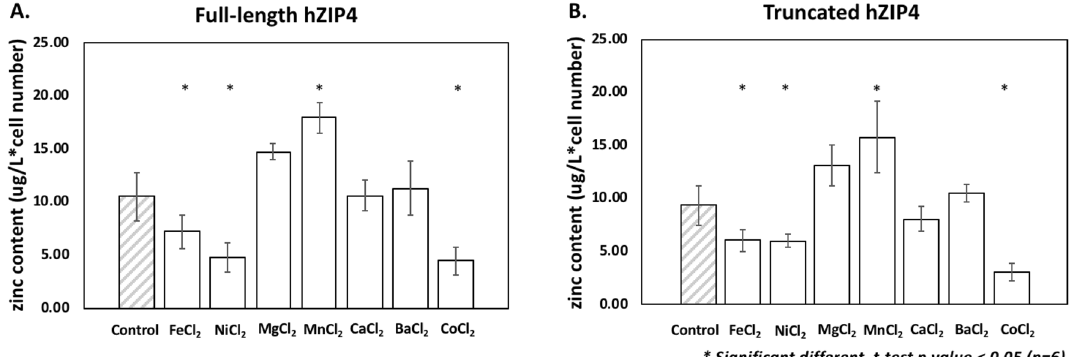
Figure 5. Competition of zinc transport with a series of divalent cations. To exam which divalent cations inhibit hZIP4-meidated Zn 2+ transport. HEK293 cells expressing hZIP4 ( A ) or truncated hZIP4 ( B ) were pre- incubated in 600 µM ZnCl 2 (control), FeCl 2 , NiCl 2 , MgCl 2 , MnCl 2 , CaCl 2 , BaCl 2 or CoCl 2 complemented media, separately. The transport was initiated by adding 5 µM Zn 2+ . * Statistically significant, t-test p value < 0.05 (n = using the number of fluorescent molecules calculated from the amplitude of the autocorrelation curves and the